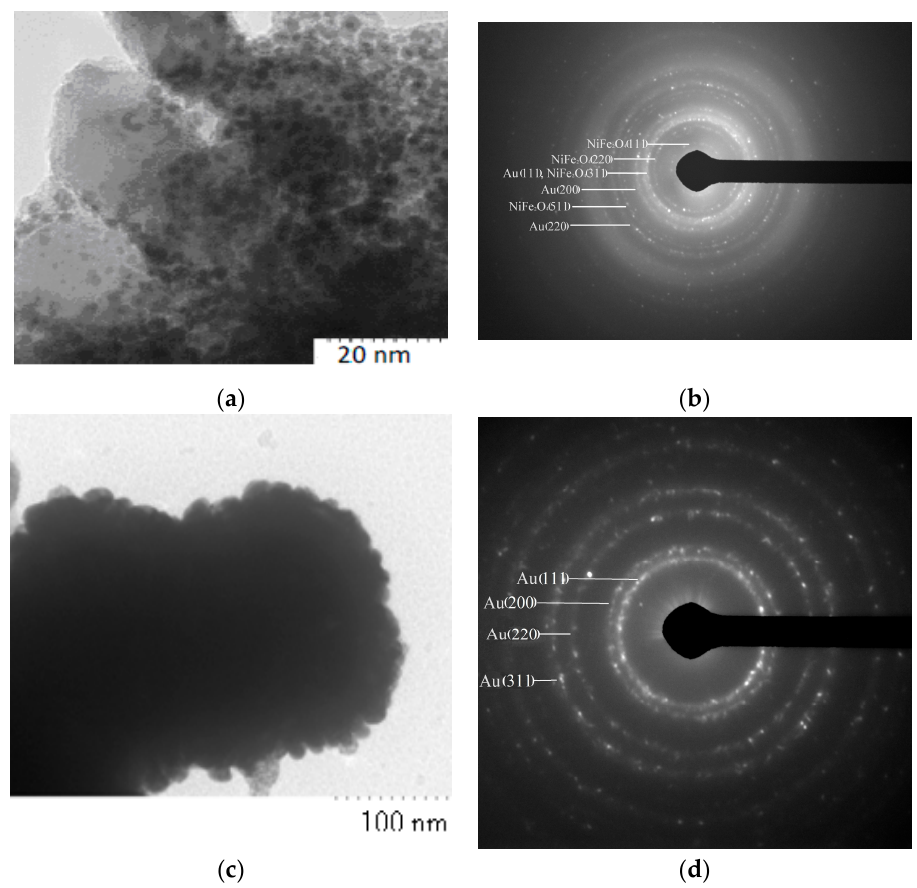
Figure 3. TEM images ( a , c ) and electron diffraction patterns ( b , d ) of hybrid NiFe 2 O 4 @Au NPs after methionine-directed gold deposition under conditions in Figure 2: ( a , b ) Single-stage coating; ( c , d ) three-stage coating.